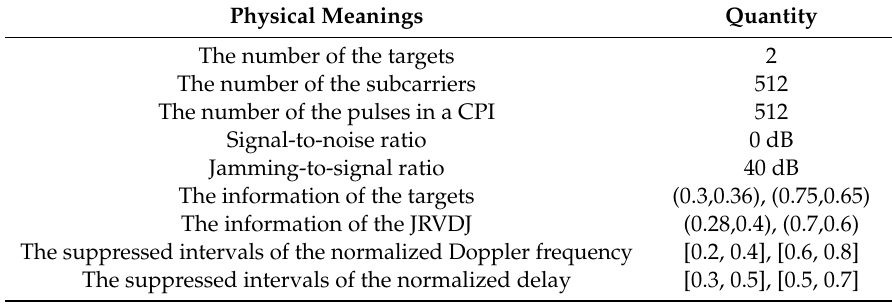
Table 3. Simulation Parameters for Suppressing JRVDJ.